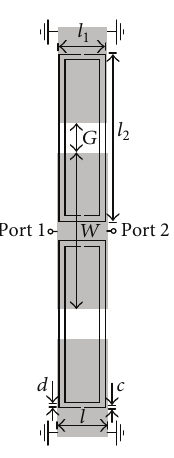
Figure 4: Unit cell of a CPW transmission line loaded with a pair of SRRs designed to enhance coupling between resonators of neighboring cells. Dimensions are 𝑊 = 9.1 mm, 𝐺 = 1.7 mm, = 2.8 mm, and 𝑙 = 9.8 mm. The 𝑙 = 3 mm, 𝑐 = 𝑑 = 0.15 mm, 𝑙 1 2 Bloch waves propagate from port 1 to port 2. From [34], reprinted with